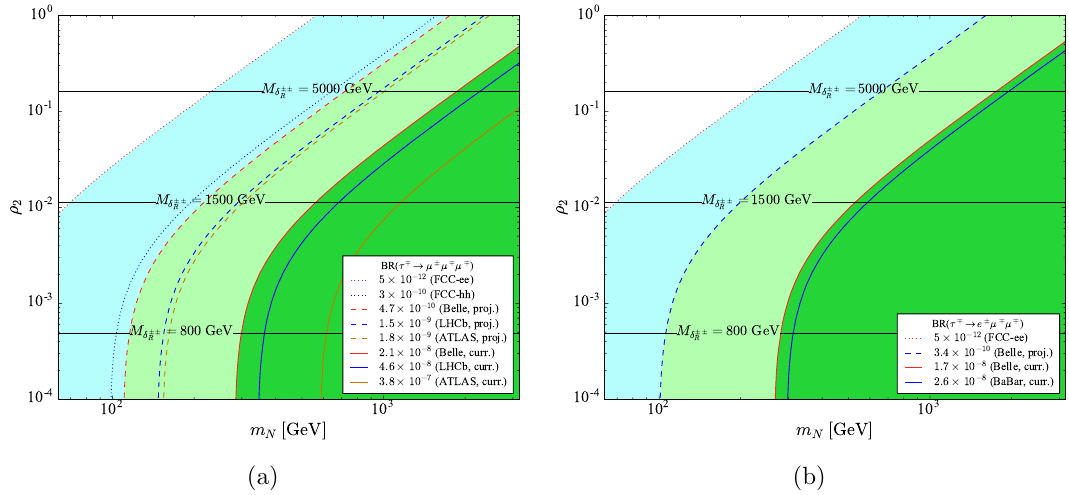
Figure 4. Current and future branching ratio limits in the parameter plane of the right-handed neutrino masses m N and the parameter (cid:26) 2 for the LRSM for the benchmark scenario BP1. (a) Shows the limits from the decay (cid:28) (cid:7) ! (cid:22) (cid:6) (cid:22) (cid:7) (cid:22) (cid:7) , and (b) shows the limits from the decay (cid:28) (cid:7) ! e (cid:6) (cid:22) (cid:7) (cid:22) (cid:7) . The solid black lines represent constant values of the mass of the doubly charged Higgs (cid:14) (cid:6)(cid:6)